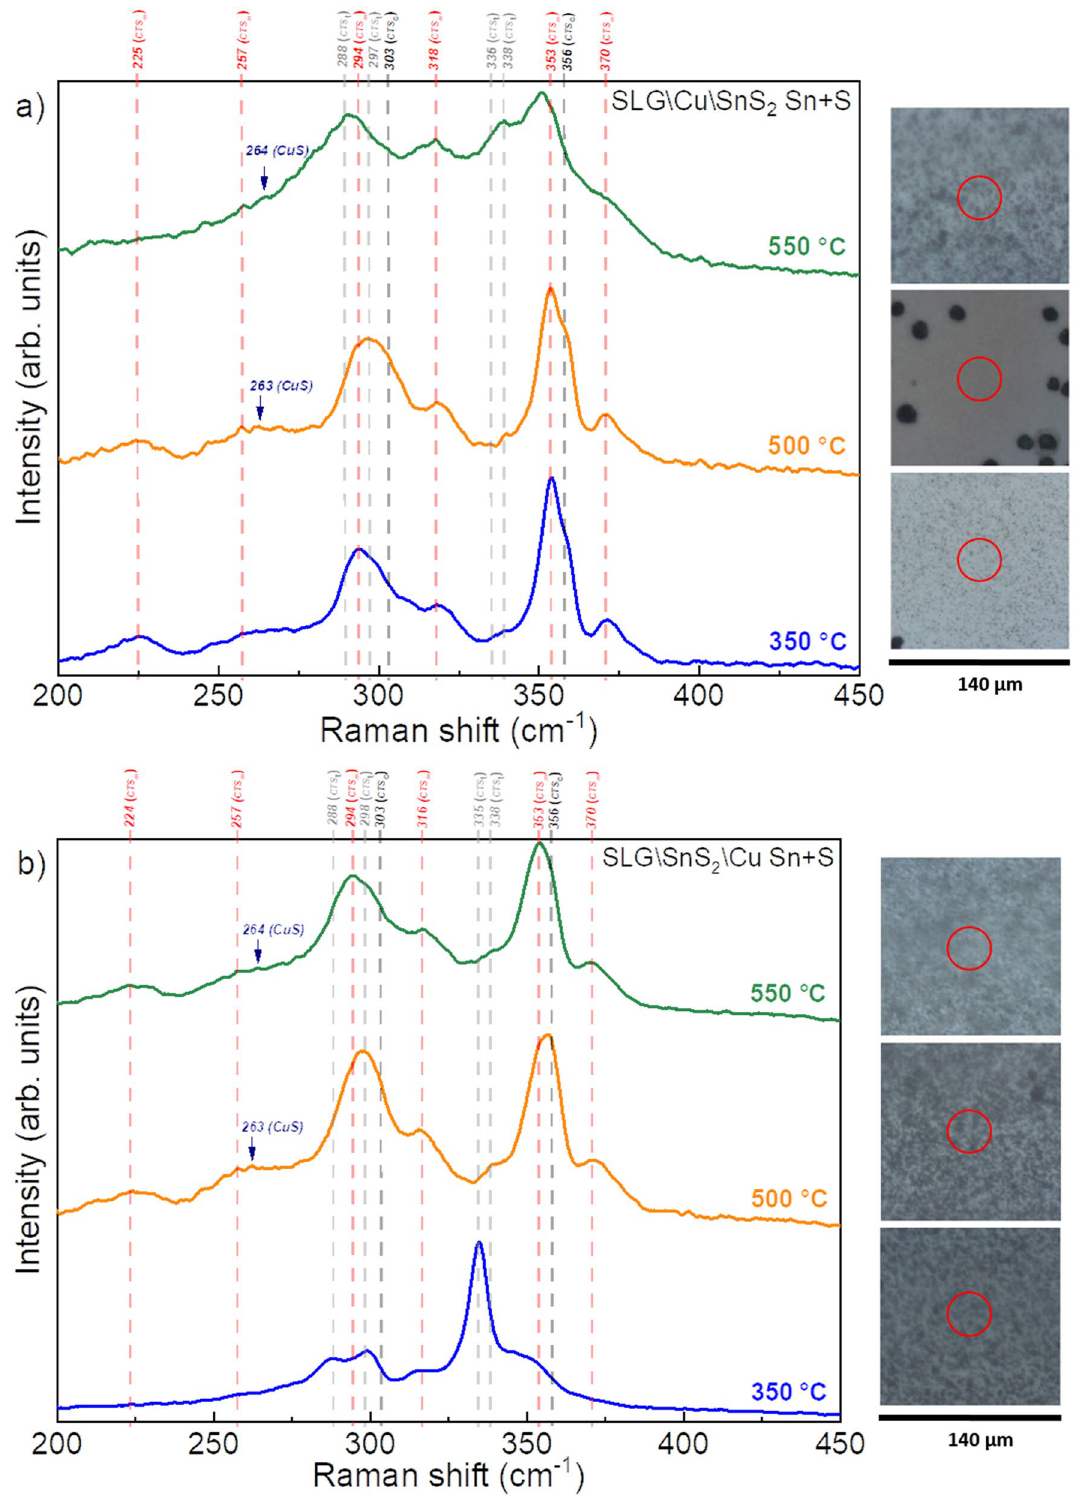
Figure 7. Raman spectra of the CTS films annealed under Sn + S atmosphere at different temperatures measured using a 633 nm wavelength. ( a ) SLG\Cu\SnS 2 , ( b ) SLG\SnS 2 \Cu stacks. The dashed vertical lines represent the Raman shifts of all identified or possible phases. On the right side, the relative optical images with the measured spot for each sample are